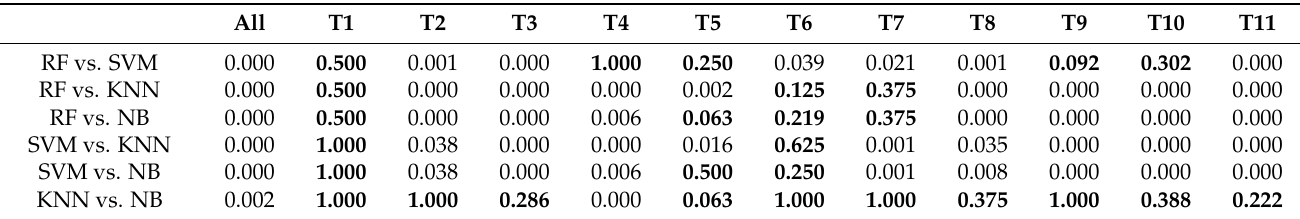
Table 7. McNemar’s test for each of the two classifiers in the pixel-based